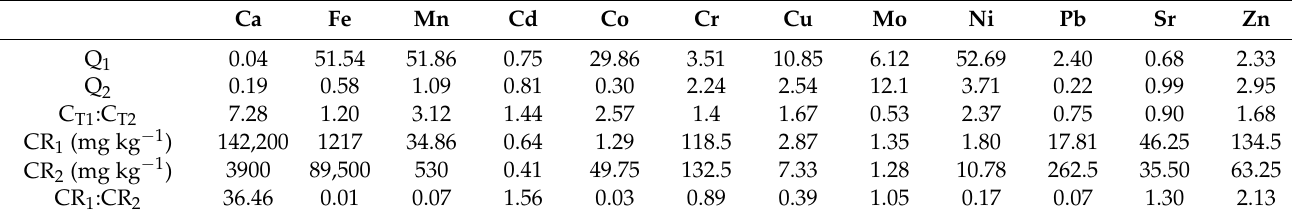
Table 4. The Q value (Q 1 , Q 2 ) and elemental content of surface soils (C T1 , C T2 ) and bedrocks (CR 1 , CR 2 ). Subscript 1 indicates soil or rock in the carbonate area, 2 indicates soil or rock in the clastic